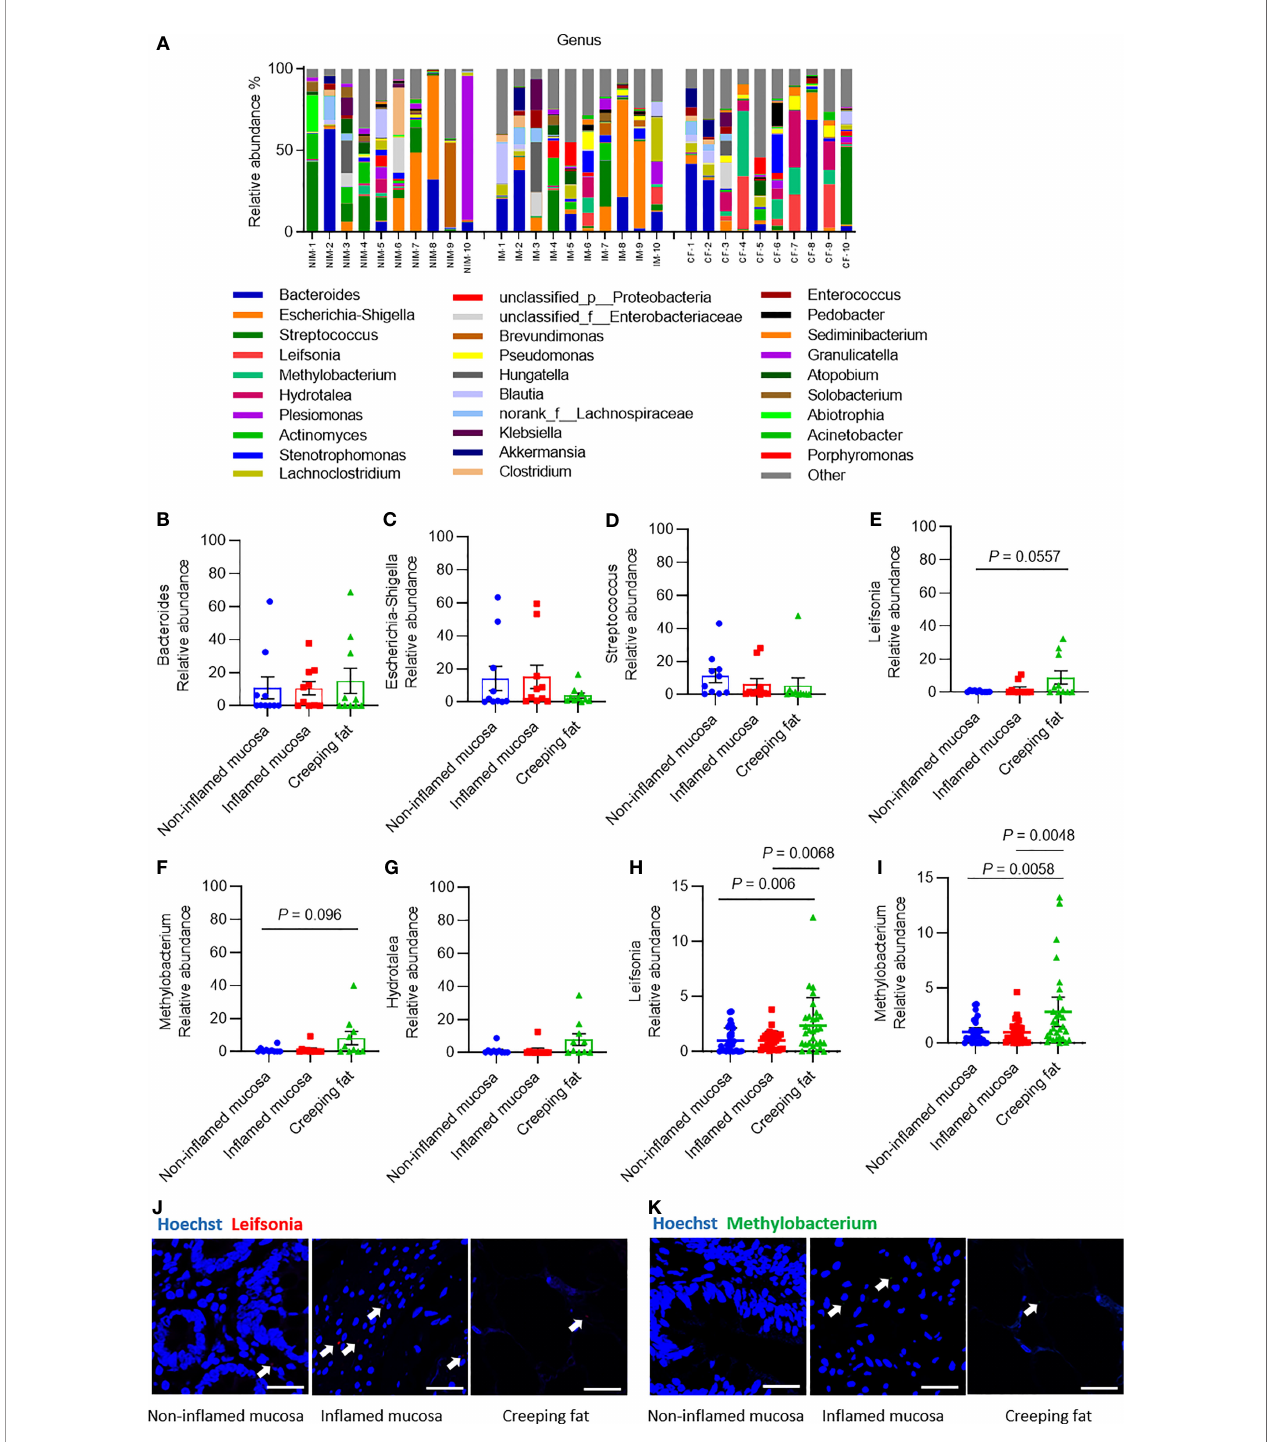
FIGURE 3 | Analysis of the predominant bacterial composition at the genus level. (A) Histograms of the predominant bacterial genera in nonin fl amed mucosa (NIM), in fl amed mucosa (IM), and creeping fat (CF) from CD patients. (B – G) Dynamic changes in the relative abundances of Bacteroides (B) , Escherichia-Shigella (C) , Streptococcus (D) , Leifsonia (E) , Methylobacterium (F) , and Hydrotalea (G) . (H) Relative abundance of Leifsonia in nonin fl amed mucosa, in fl amed mucosa, and creeping fat detected by qPCR; n = 30. (I) Relative abundance of Methylobacterium in nonin fl amed mucosa, in fl amed mucosa, and creeping fat detected by qPCR; n = 30. (J, K) FISH experiment with speci fi c probe for Leifsonia and Methylobacterium . Scale bar, 50 m m. Data are presented as the mean ± 95% CI; p -value calculated by one-way ANOVA with Tukey ’ s multiple comparisons